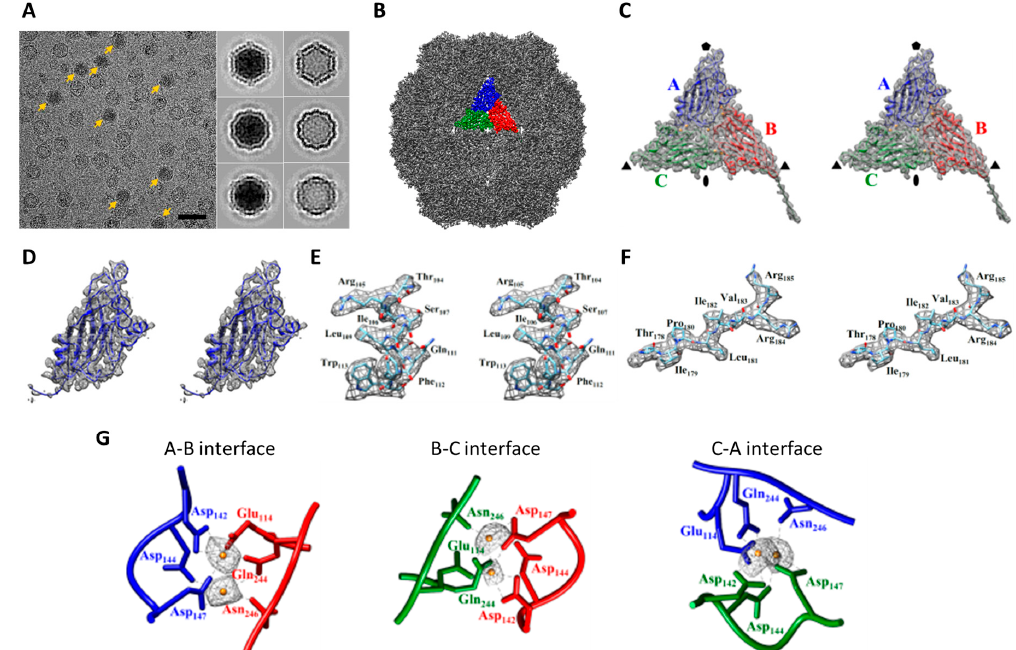
Figure 5. The cryo-EM structure of MrNV particle from Talos Arctica. ( A ) A typical cryo-EM micrograph of ice-embedded MrNV particles. The full MrNV particles are indicated by yellow arrows. The selected 2D class-averaged images of MrNV full and semi-empty particles are shown in the insets. Bar: 50 nm. ( B ) Surface view of MrNV semi-empty particle density map colored in gray. An asymmetric unit of three subunit is highlighted and each subunit is colored differently: subunit A in blue, B in red, and C in green. ( C ) Stereo pair of enlarged views of an asymmetric unit containing subunits A, B, and C with the atomic models enveloped within. ( D ) A stereo pair of the enlarged views of a subunit (subunit A) with the atomic models enveloped within. ( E ) A stereo pair of a α -helix in subunit A composed of residues 104–113; the side chain details are visualized in the segmented density (gray mesh). ( F ) A stereo pair of a β -strand composed of residues 232–237 in subunit A; the side chain details are visualized in the segmented density (gray mesh). ( G ) The models of the side-chains of the calcium-binding motif and other coordinating residues together with the electron density of two putative calcium ions at the A-B, B-C, and C-A interfaces are displayed (subunit A in blue, B in red, and C in